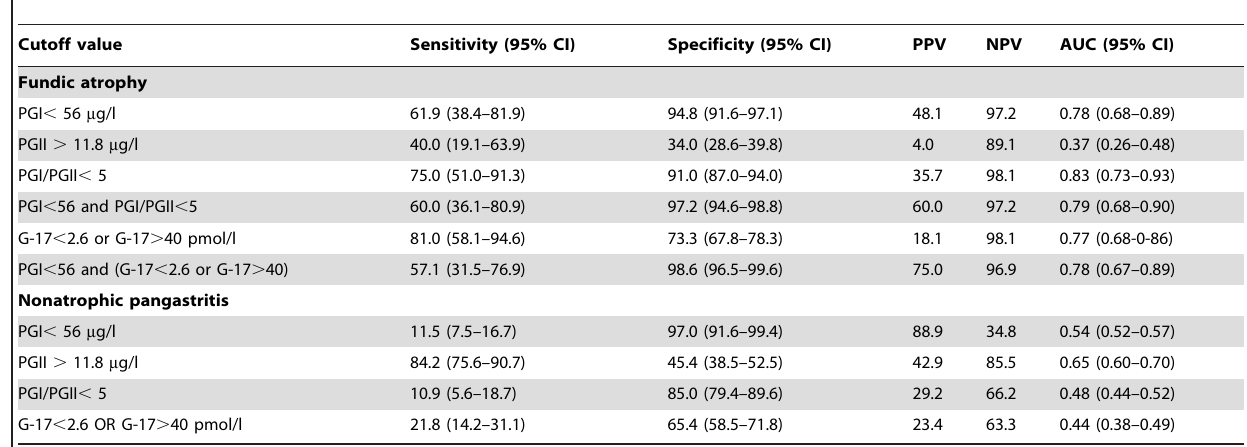
Table 2. Screening characteristics of PGI and PGI/PGII ratio for diagnosis of fundic atrophy and nonatrophic pangastritis.